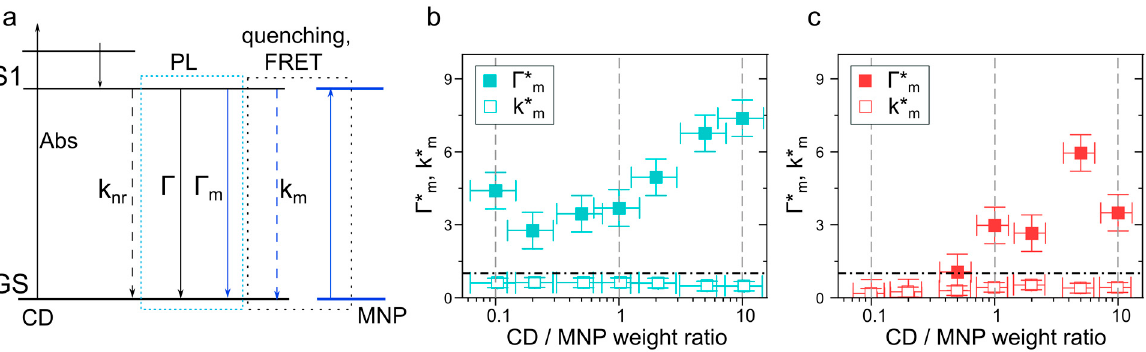
Figure 6. ( a ) Jablonski diagram illustrating transitions occurring in the CD–MNP complex. After absorption (Abs) of the incident light by CDs, it rapidly (10 − 12 –10 − 10 s) relaxes to the lowest excited